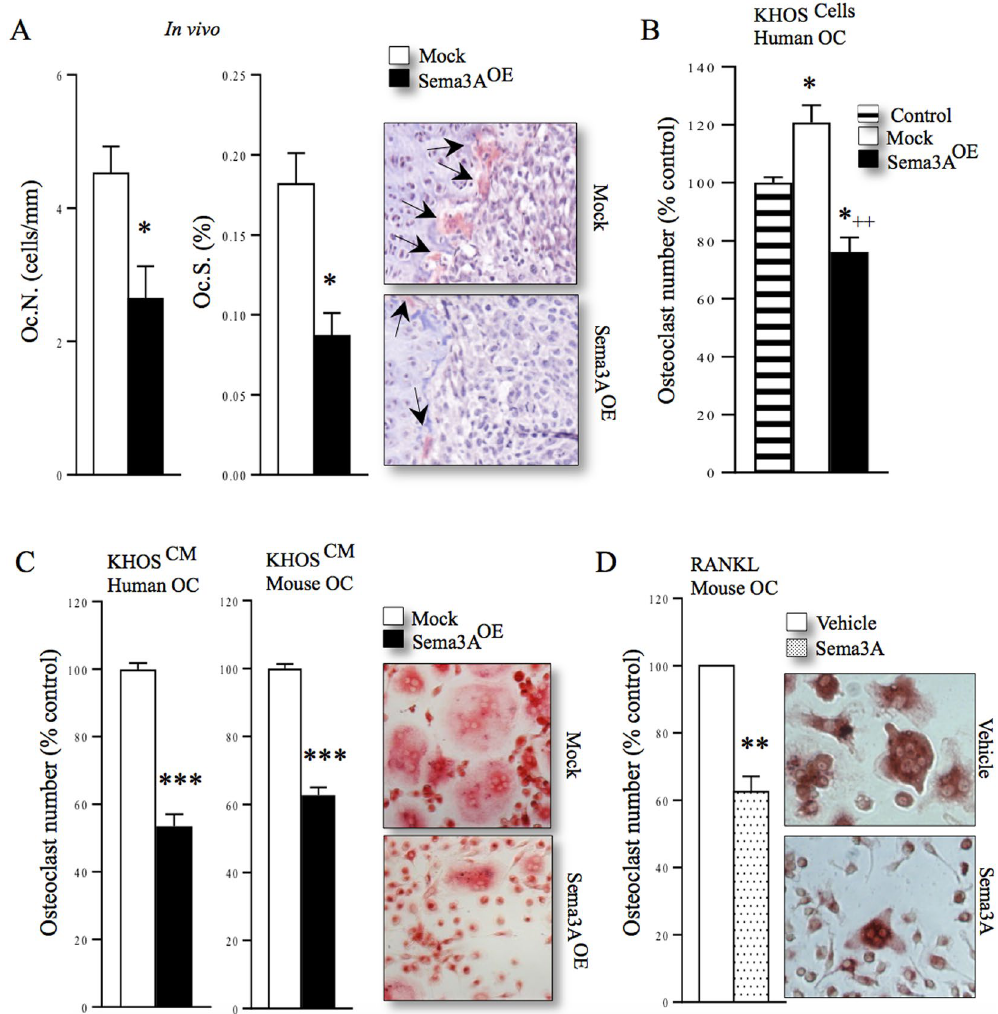
Figure 5. Osteosarcoma-derived Sema3A reduces osteotropic activity of KHOS cells. ( A ) In vivo osteoclast number (Oc.N, left) and osteoclast surface (Oc.S, middle) from tibial metaphysis from mice from the experiment described in Fig. 3. Representative photomicrographs of TRAcP positive osteoclasts indicated with solid arrows from the experiment described are shown on the right. ( B ) In vitro human osteoclastogenesis in RANKL-stimulated human peripheral blood monocytes co-cultured with human KHOS cells overexpressing Sema3A (Sema3A OE ) or mock control as assessed by TRAcP staining. ( C ) In vitro mouse and human osteoclastogenesis in RANKL-stimulated human peripheral blood monocytes (left) and mouse bone marrow cells (middle) exposed to conditioned medium from human KHOS cells overexpressing Sema3A (Sema3A OE ) or mock control. Representative photomicrographs of human osteoclasts from the experiment described are shown on the right. ( D ) In vitro osteoclastogenesis of murine M-CSF- and RANKL-stimulated bone marrow cultures in the presence and absence of Sema3A (300 ng/ml). Representative photomicrographs of mouse osteoclasts from the experiment described are shown in the right. Data are mean ± SEM, n = 3 * p < 0.05, ** p < 0.01 *** p < 0.001, ++ p < 0.01 of